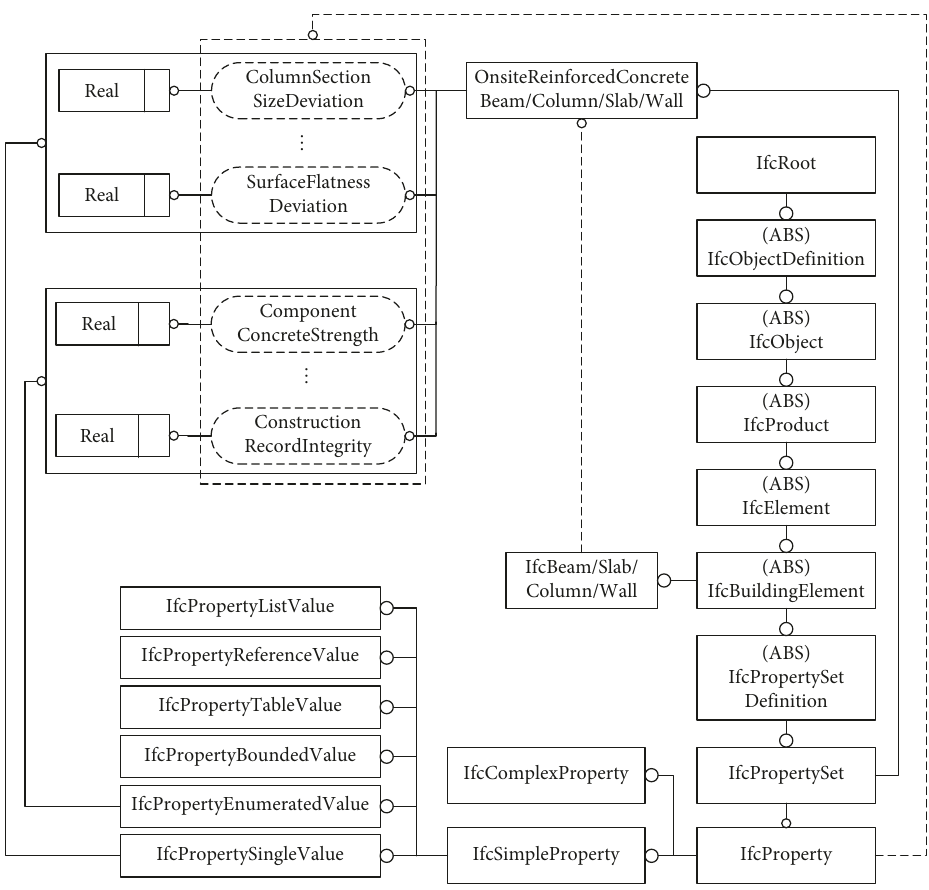
Figure 6: EXPRESS-G diagram for quality evaluation